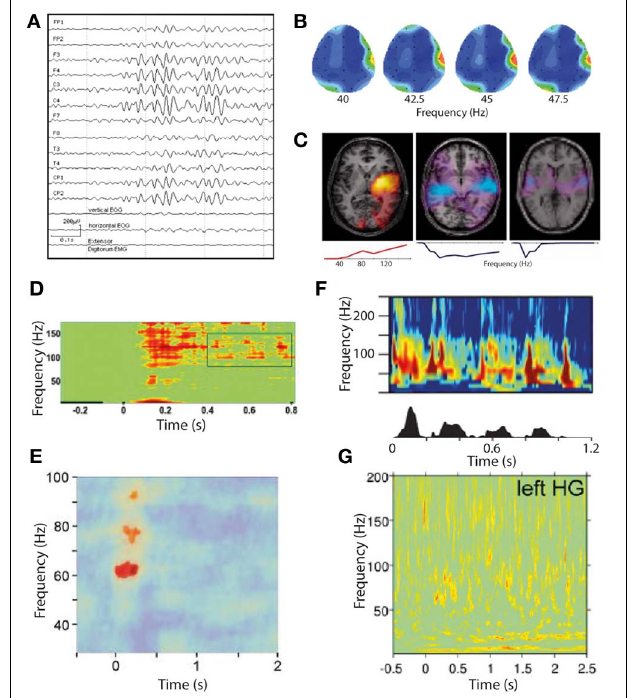
FIGURE 4 | Gamma oscillations in phantom and normal somatosensory and auditory perception. (A–C) Gamma oscillations in phantom perceptual conditions are very high amplitude and easily visualized. (A) Raw scalp EEG waveforms from a patient with somatic phantom perception. Note the gamma oscillations dominate the entire EEG spectrum, whereas even the strongest gamma oscillations in response to external sensory stimuli cannot be seen without significant post-processing (reproduced with copyright-holder’s permission from Baldeweg et al., 1998). (B) Scalp topography of resting-state gamma power in a patient with chronic tinnitus. Note the focus of gamma power, predominantly in a relatively narrow frequency band, over the right temporal lobe coinciding with auditory cortex (reproduced with permission from Ashton et al., 2007). (C) Individual patient correlates of increased tinnitus intensity (in response to small changes in perceived tinnitus intensity), in auditory cortex measured with MEG, occurring in a residual inhibition (RI; left) and residual excitation (RE; middle and right) paradigm. Brain slice overlays illustrate the spatial distribution of gamma power changes, and plots below illustrate the frequency spectra of these power changes. Note the positive correlation of gamma power with tinnitus intensity in RI and the negative correlation in RE. Also note the variable spectrum of the gamma oscillations, being broadband in two cases and narrowband in one (reproduced with permission from Sedley et al., 2012). (D–G) Gamma oscillations in response to external sensory stimulation are high-frequency, broadband and weak in amplitude. (D) Somatosensory cortex gamma oscillations in response to tactile stimulation, recorded with ECoG (reproduced with copyright-holder’s permission from Ray et al., 2008). (E) Somatosensory cortex gamma oscillations in response to painful stimuli, recorded with MEG. Note the weaker and more limited response obtained with MEG than with ECoG as in (D) (reproduced with copyright-holder’s permission from Gross et al., 2007). (F) Auditory cortex gamma oscillations recorded with depth electrodes (upper) in response to a speech stimulus (speech envelope shown in lower panel), with a clear burst of gamma oscillations following each speech sound after a short delay (reproduced with permission from Nourski et al., 2009). (G) Auditory cortex gamma oscillations recorded with MEG in response to equivalent speech paradigm as in (F) . Note the very weak and indistinct response (despite procedural optimization; reproduced with copyright-holder’s permission from Millman et al.,